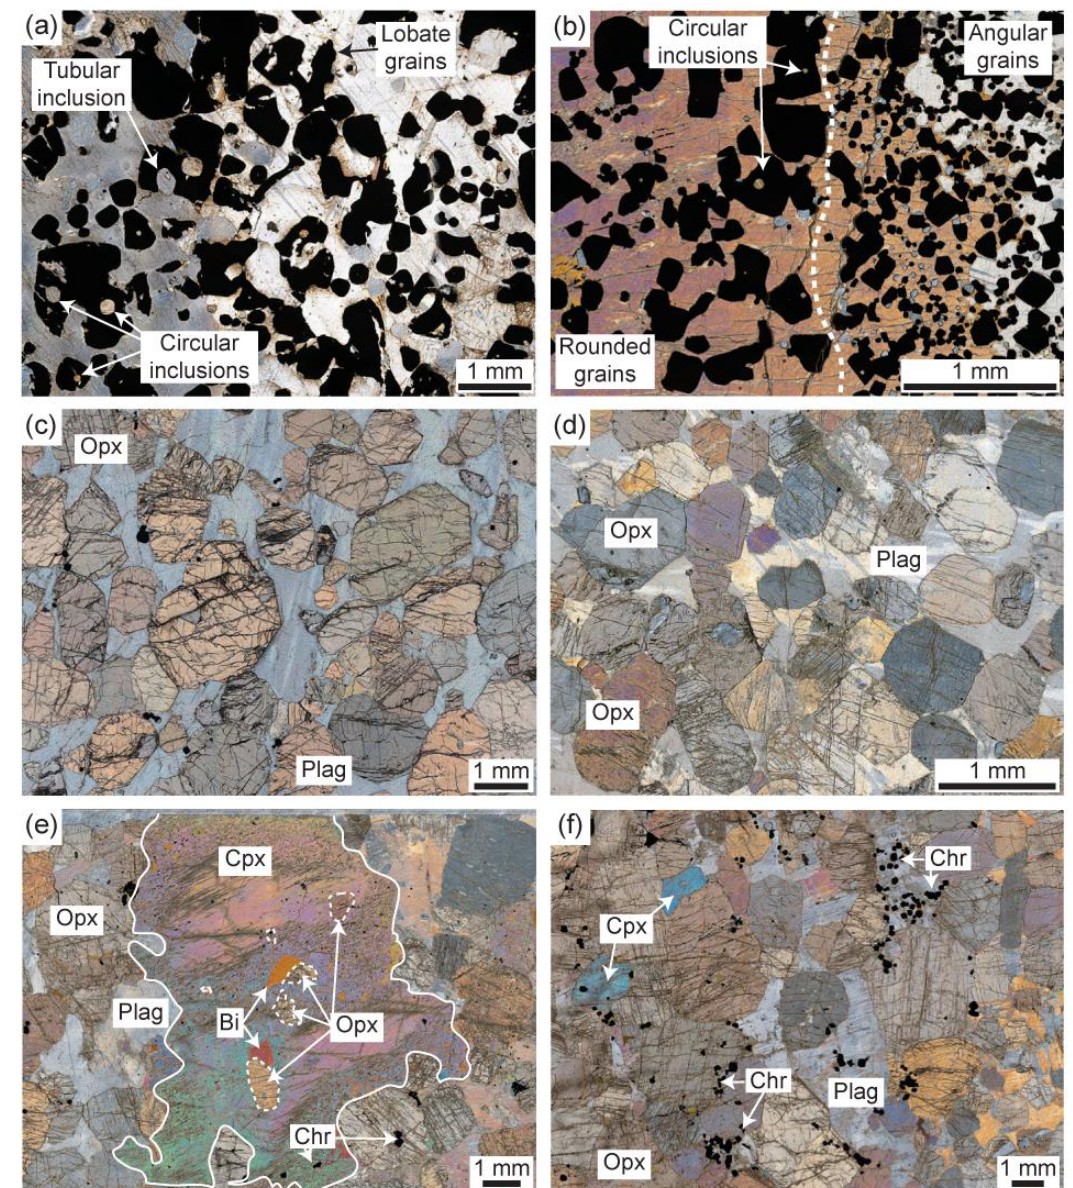
Figure 6. Photomicrographs from the Merensky Unit, photographed under differential interference contrast (DIC) as an approximation of circularly polarised light (CPL). Way up of all photographs is to the right: ( a ) Basal chromitite with circular/tubular inclusions and lobate Cr-spinel grains; ( b ) Middle chromitite with large Cr-spinel grains at the base in contact with megacrystic feldspathic orthopyroxene; ( c ) Feldspathic orthopyroxenite with subhedral to euhedral Opx grains and oikocrystic Plag; ( d ) Feldspathic orthopyroxenite with subhedral to euhedral Opx grains and oikocrystic Plag; ( e ) Large oikocrystic Cpx grain hosting small, euhedral to anhedral Opx grains (dashed lines); ( f ) Disseminated Cr-spinel grains within feldspathic orthopyroxenite; Abbreviations: Opx = orthopyroxene; Cpx = clinopyroxene; Chr = Cr-spinel; Plag = plagioclase; Bi = biotite.